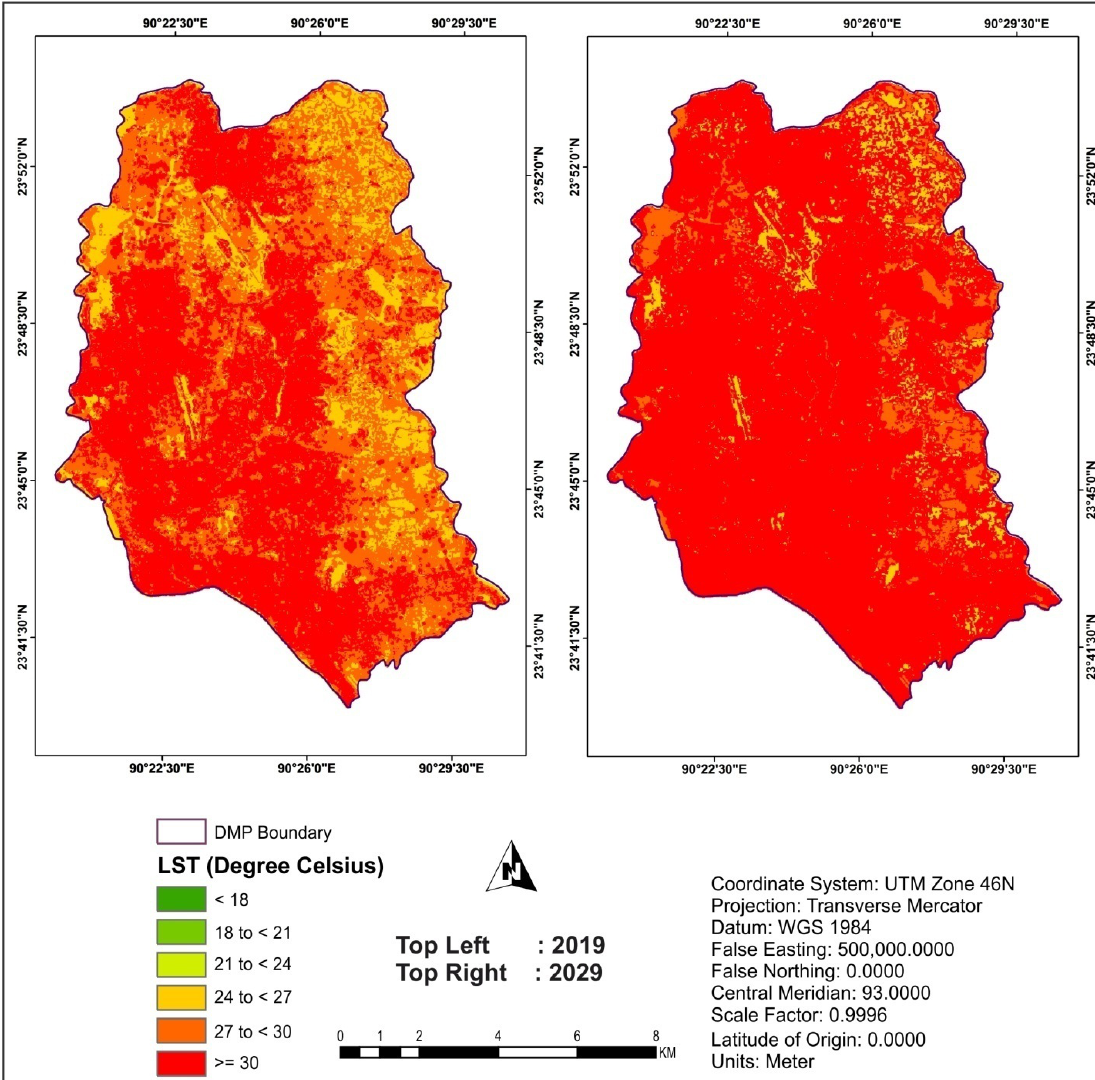
Figure 14. The simulated LST maps of DMP area (2019 and